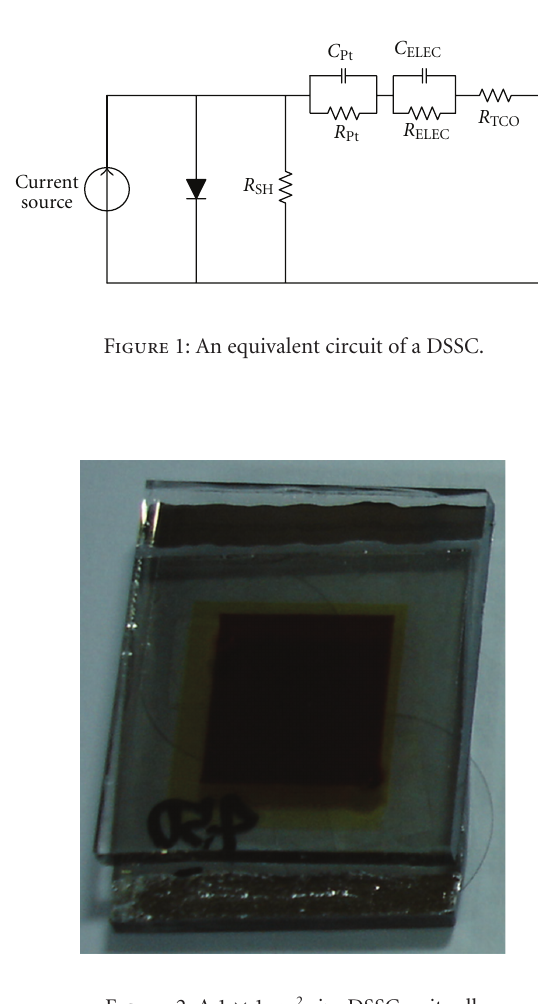
Figure 2: A 1 × 1 cm 2 size DSSC unit